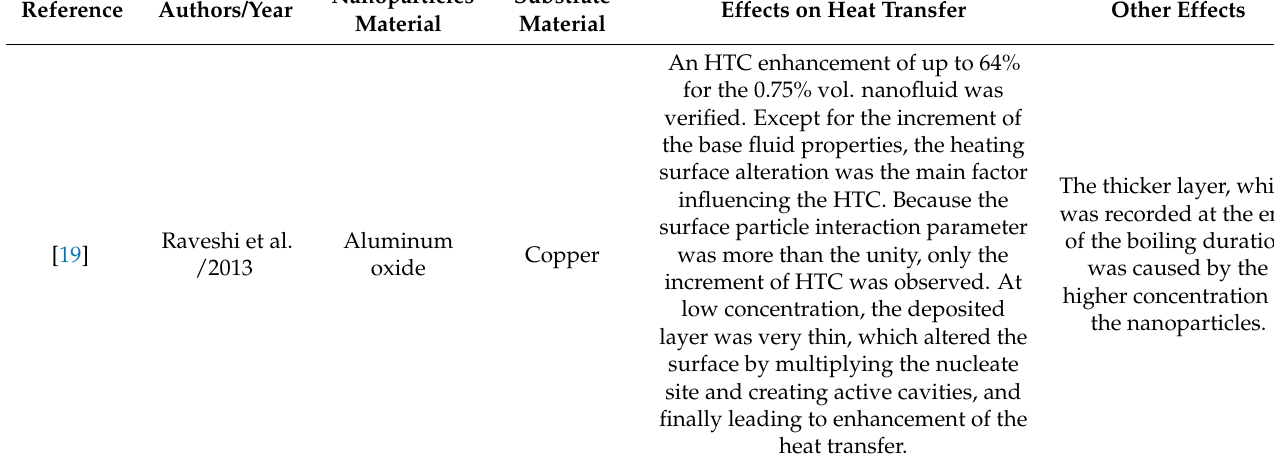
Table 1. Main recent experimental works on boiling-induced nanoparticle deposition.